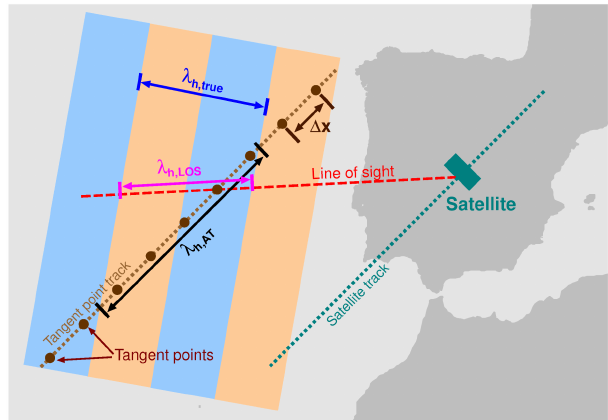
Figure 2. Illustration of an example how the apparent horizontal wavelength λ h , AT parallel to the satellite tangent point track (mea- surement track) and the apparent horizontal wavelength λ h , LOS par- allel to the satellite line of sight (LOS) could differ from the true horizontal wavelength λ h , true of an observed gravity wave. These differences strongly depend on the relative orientations of the ob- served gravity wave, of the LOS, and of the direction of the tangent point track; however, λ h , LOS and λ h , AT will always overestimate λ h , true . Light blue and light orange shaded areas indicate areas of negative and positive phases, respectively, that would be obtained by a horizontal section through an idealized plane gravity wave. Bold brown dots indicate the discrete sampling of this wave by sin- gle altitude profiles observed by the satellite instrument. The hori- zontal sampling step is denoted as (cid:49)x